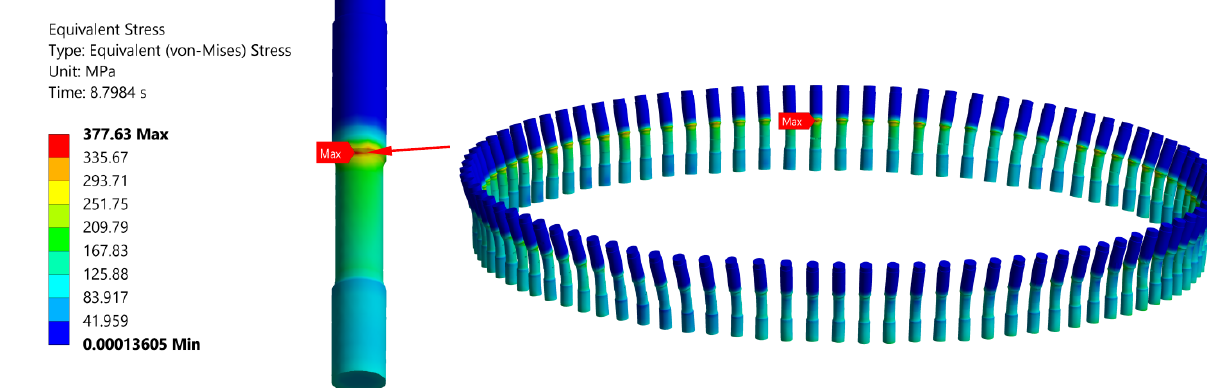
Figure 22. Von Mises stress distribution of the head-cover bolts.